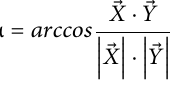
Frontiers in Bioengineering and Biotechnology |